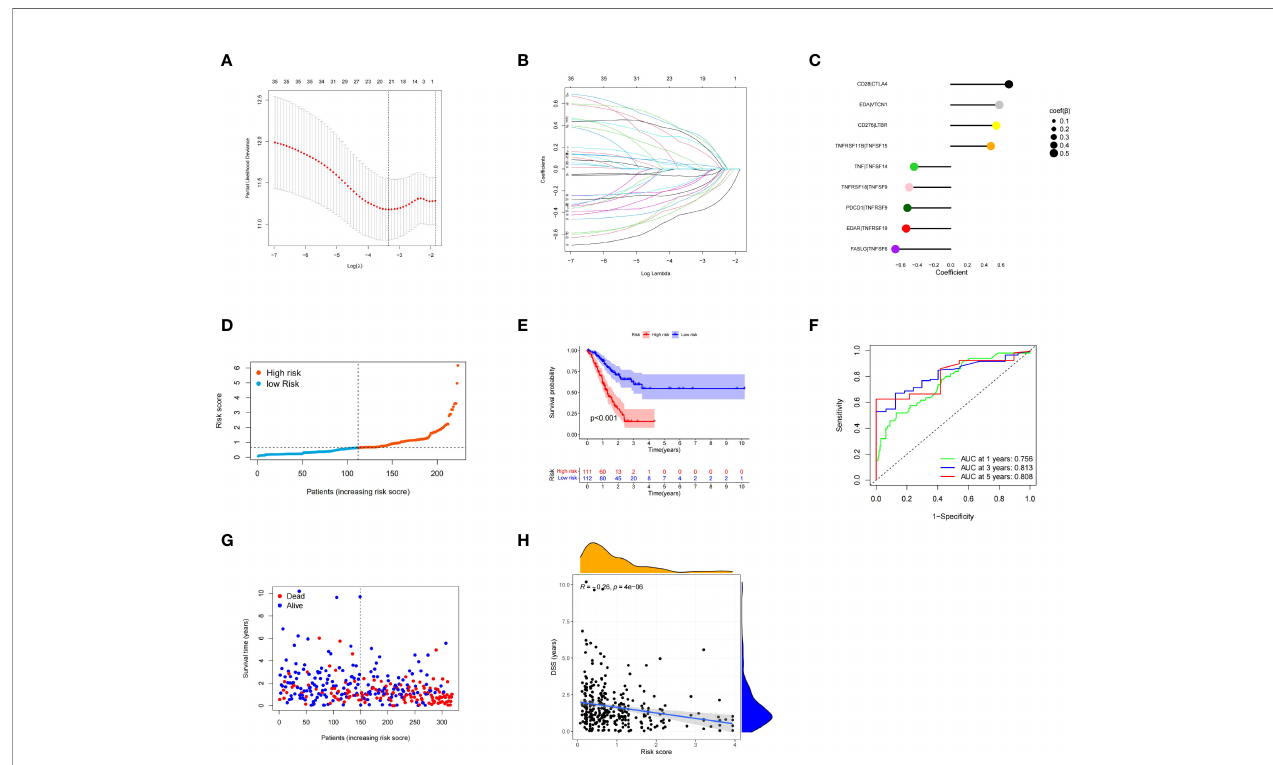
FIGURE 4 | Multivariate least absolute shrinkage and selection operator (LASSO) regression analysis. Nine costimulatory molecular gene pairs (CMGPs) were identi fi ed using Cox regression analysis to create the prognostic signature (A, B) . Coef fi cient of the nine CMGPs (C) . The risk score of each patient was generated, and the 223 patients were divided into high- and low-risk groups according to the median risk score (0.6378) (D) . Survival curves in the high- and low-risk groups (E) . Time-dependent receiver operating characteristic (ROC) curve of the risk model (F) . The number of deaths increased as the risk score increased; this trend was more obvious with the increase in the risk score, especially in the very high-risk population. There were signi fi cant differences in the clinical outcomes at the symmetrical positions of the left and right sides of the median value, especially when the risk score was <100 and >200 (G) . Disease-speci fi c survival (DSS) and risk score correlation (H)